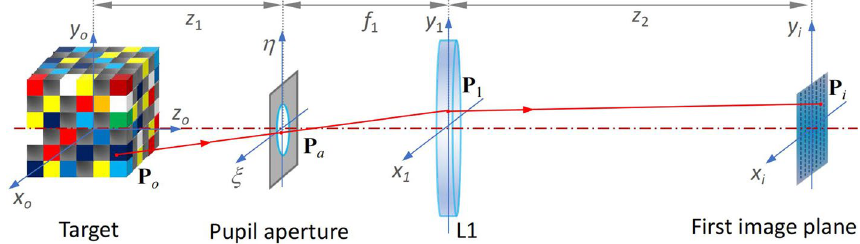
Fig. 2 The optical path and structure of the fore optics. P o means an object point on the hypercube target. A random light ray from P o intersects the pupil aperture and L1 at P a and P 1 respectively. The light ray from P 1 intersects the image mapper at P